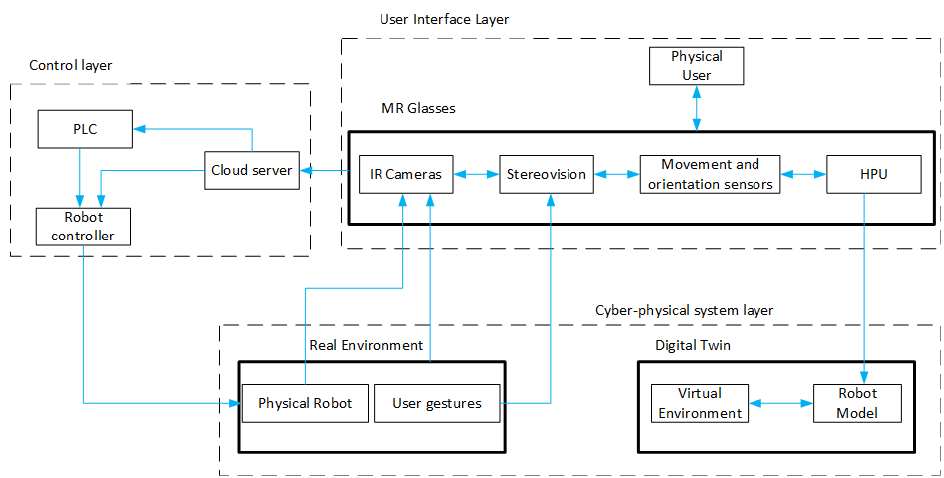
Figure 5. Architecture of a fully active system control and distance measurement